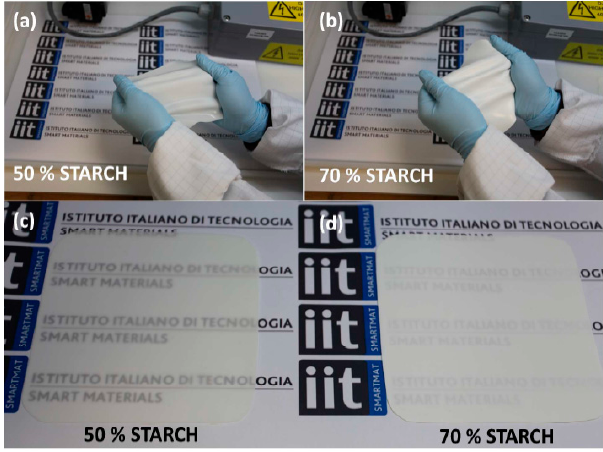
Figure 9. Photographs of bio-elastomers containing ( a ) 50 wt% and ( b ) 70 wt% of unmodified corn starch and examples of their transparency in ( c , d ), respectively. Adapted from [57] with permission from American Chemical Society and Copyright Clearance Center, 2015.